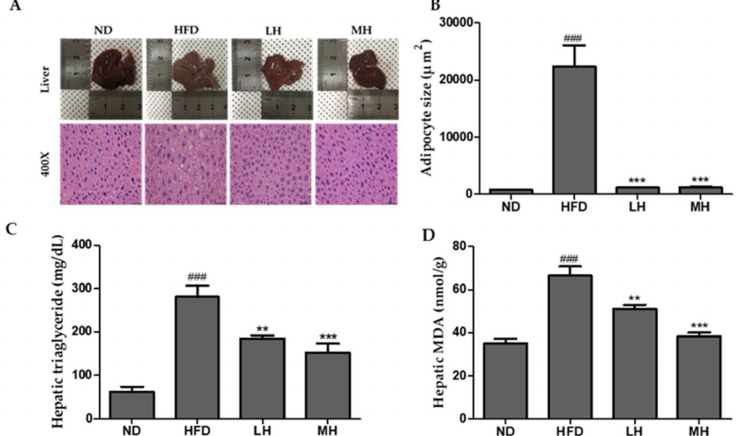
Figure 6. Effect of HBE treatment on hepatic steatosis in normal or HFD-fed mice. ( A ) Liver tissue histology (400 × ). ( B ) Adipocyte sizes of ND, HFD, LH, and MH. ( C ) The accumulation of liver